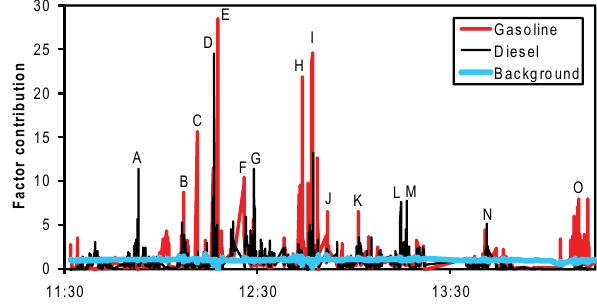
Fig. 2. Concentration profiles of gasoline, diesel, and background factors with error bars showing 95% confidence intervals. Concen- tration units vary by species, whose abbreviations are shown in Ta- ble 1.